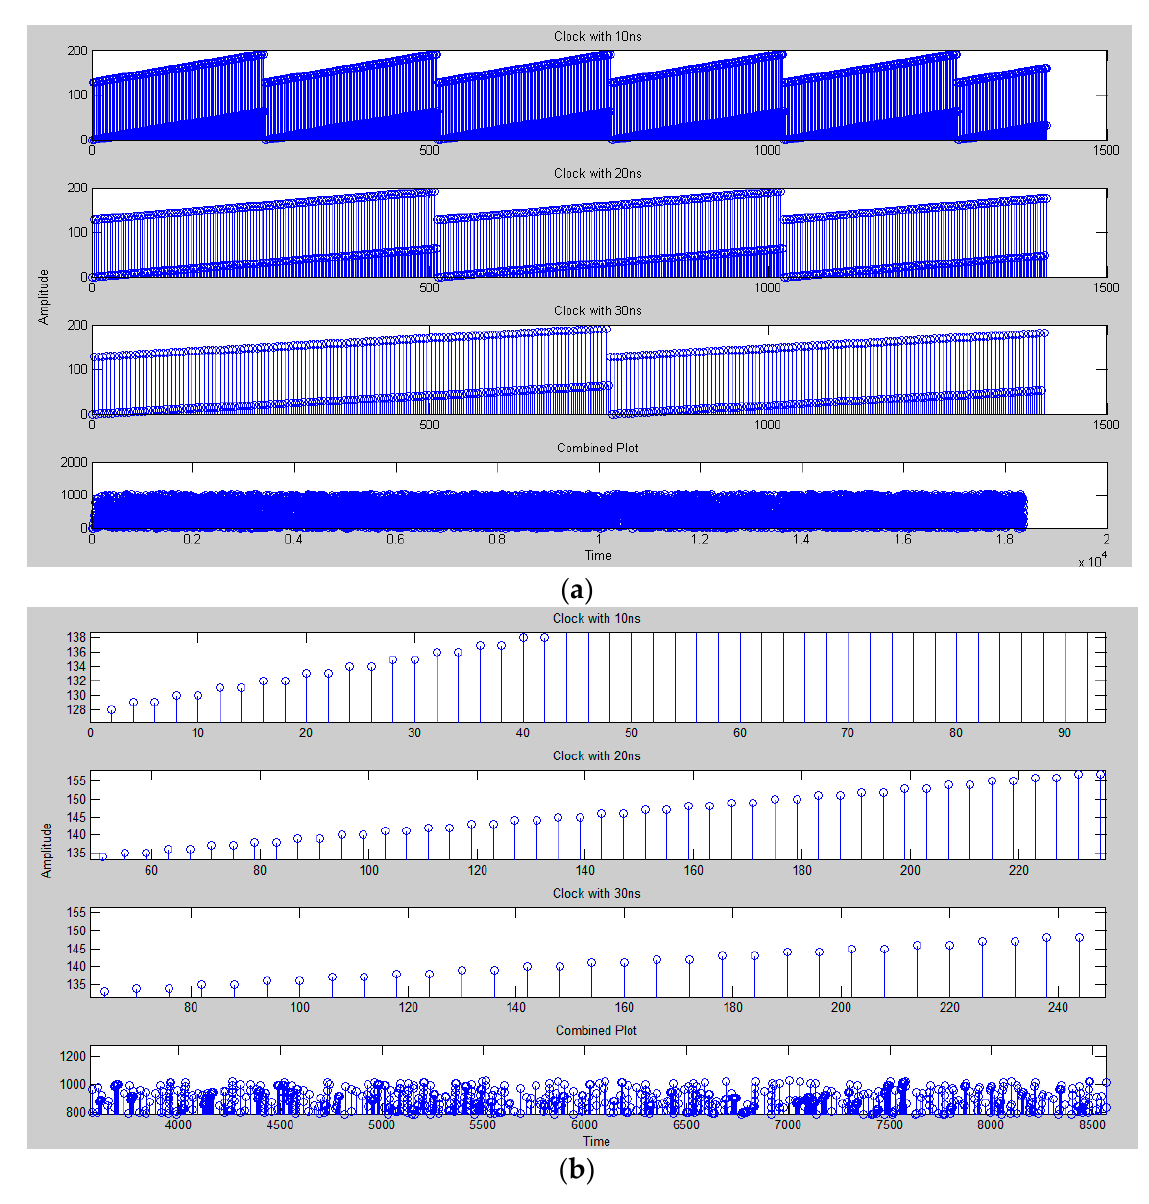
Figure 11. ( a ) Communication between PEs with delays − Simple view. ( b ) Communication between PEs with delays − Expanded view.